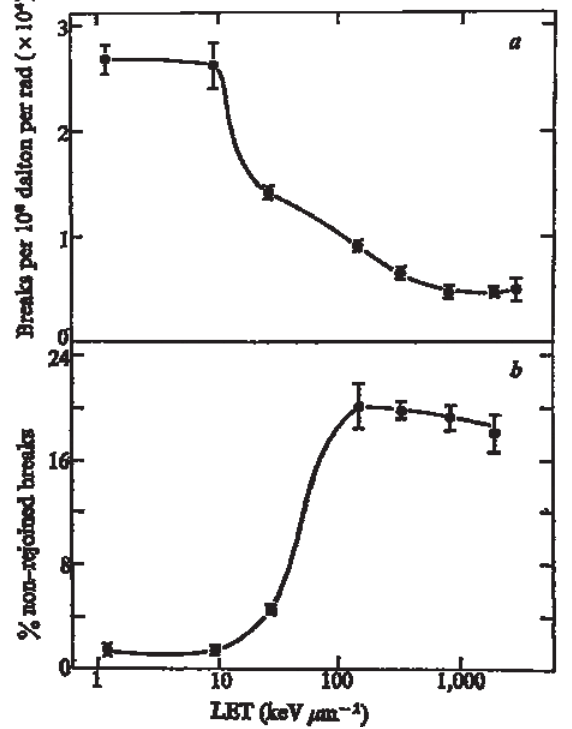
Figure 4. Induction of DNA strand breaks ( a ) and percentage of non-rejoining DNA breaks ( b ) at 8.5 h after X-ray or heavy ion irradiation in V79S171 cells. Higher LET radiation induces significantly more non-rejoined DNA breaks. Adapted from Ritter,